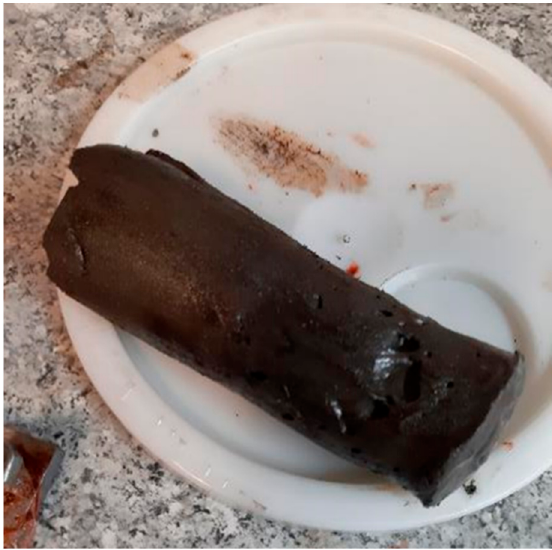
Figure 15. Consistency of Method VI with water/solids ratio of 20%, 7 days at 60 °C.